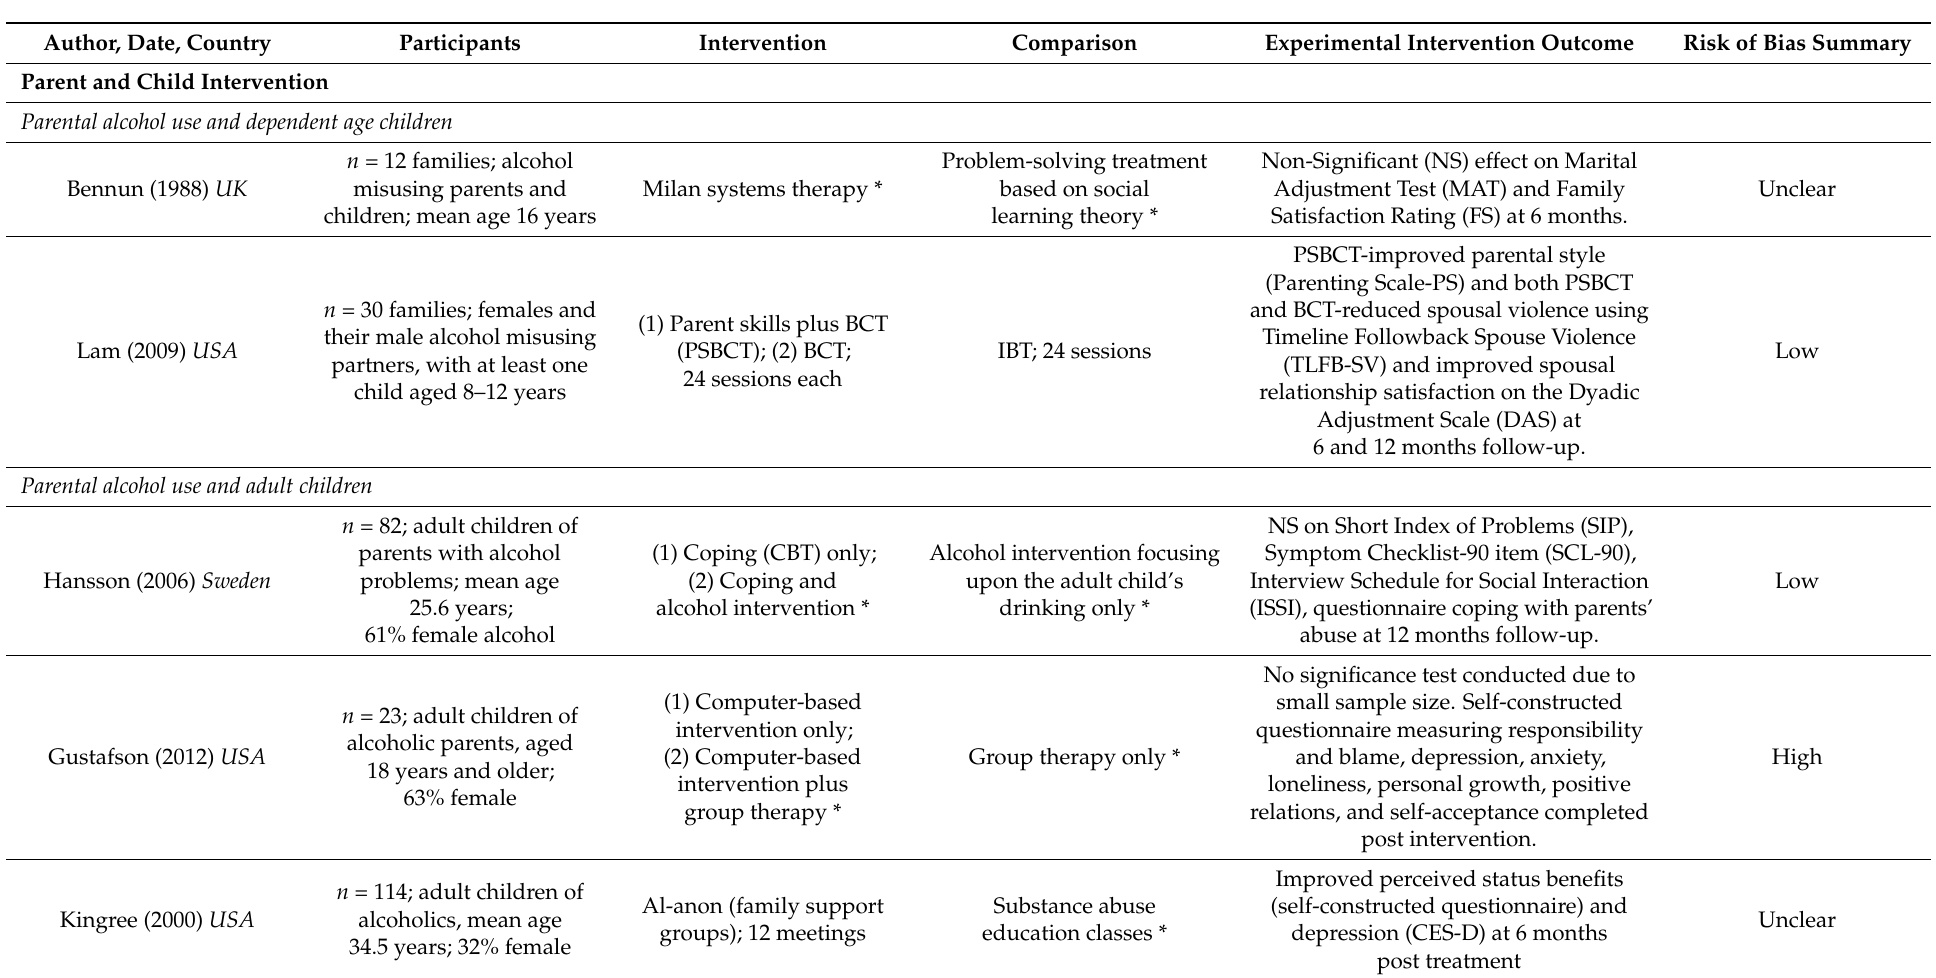
Table 2. Evidence of effectiveness from included